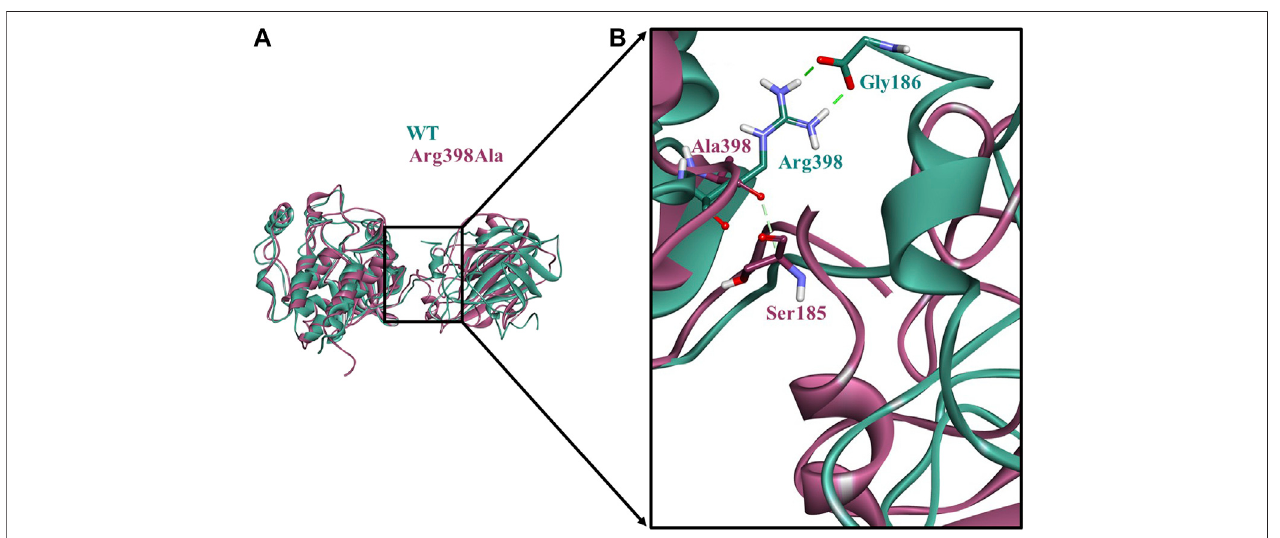
FIGURE 5 | Comparison of the conformational change at the Arg398Ala mutation site as compared with the wild-type (WT) C-Raf/RKIP structural complex obtained through molecular dynamics (MD) simulations. (A) The equilibrated native state conformation of WT (mint green) superimposed with the Arg398Ala (mauve) representative snapshot extracted at 180 ° ns. (B) Enlarged view of the conformational change at the Arg398Ala mutation site. Conventional hydrogen bonds are displayed as dark green dashed lines, while carbon-hydrogen bond is shown as a light green dashed line.